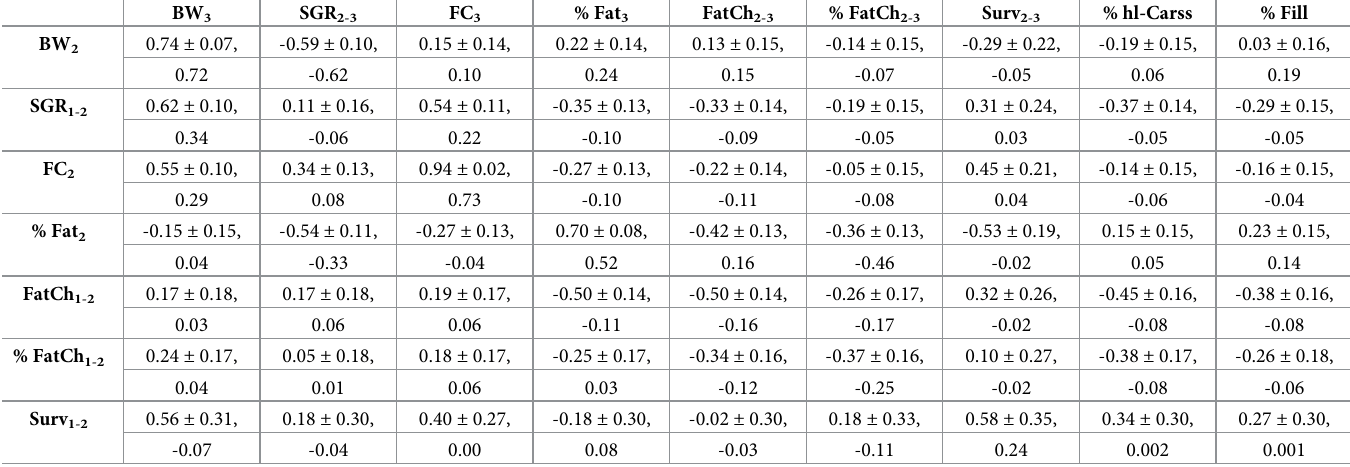
Table 3. Genetic (first line; ± S.E.) and phenotypic correlations (second line) of traits changes during overwintering and traits after overwintering (left hand side) related to traits changes during growing period and traits at market size (upper